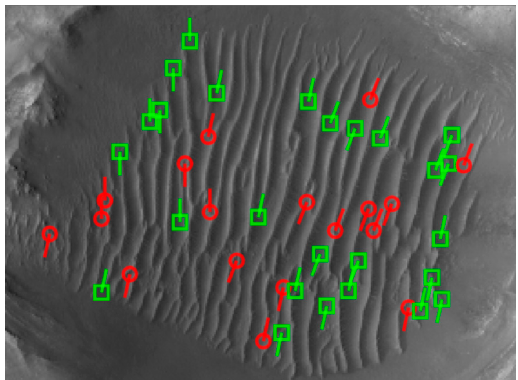
Figure 16. MINDTCT extraction from a resampled image (binned by 10 pixels). Green boxes (terminations) and red circles (bifurcations) with direction indicated by vectors from their center points.